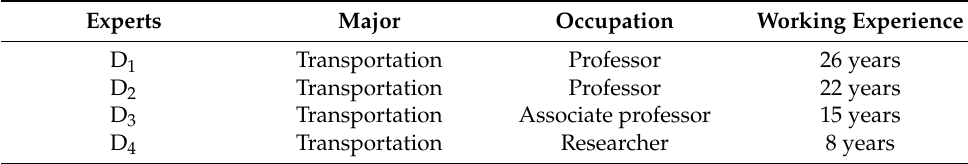
Table 2. The background of experts.